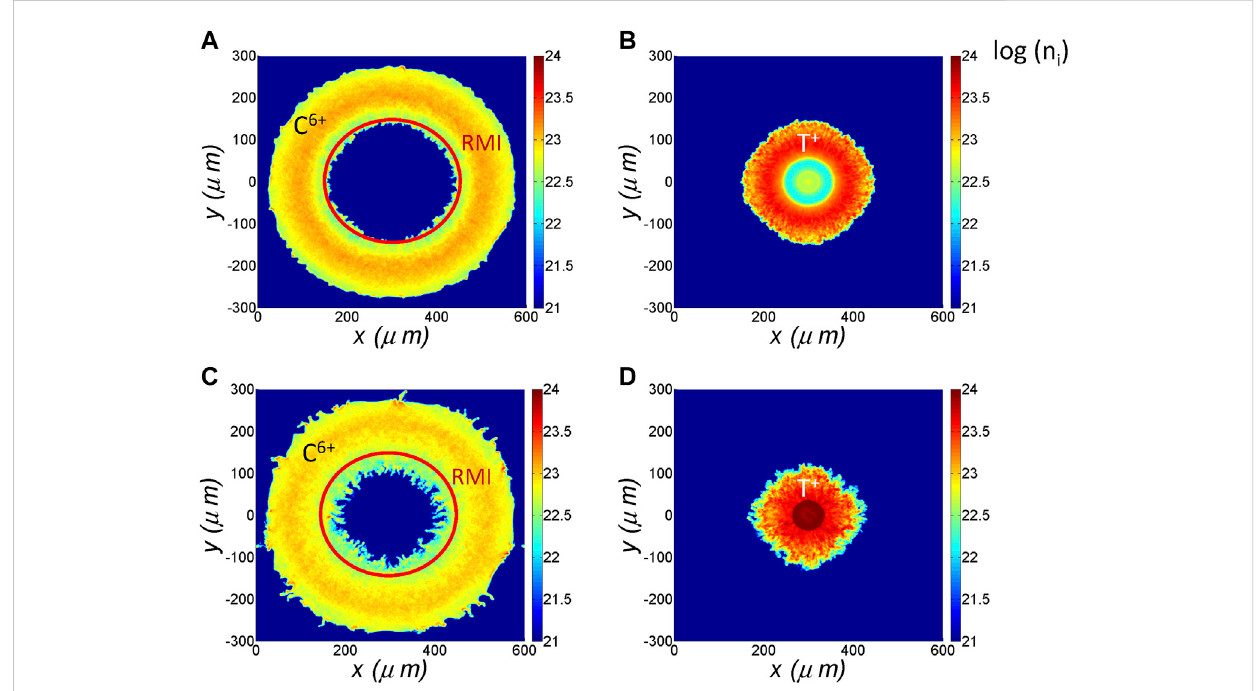
FIGURE 5 Snapshots of the 2D density of (A,C) carbon (ablator) and (B,D) tritium (fuel) in logarithm scale at (A,B) the shock collision time t = 2.41 ns and (C,D) the Bangtime t = 2.57 ns. The hydrodynamic instabilities at the ablator-DT interface are marked inside the red